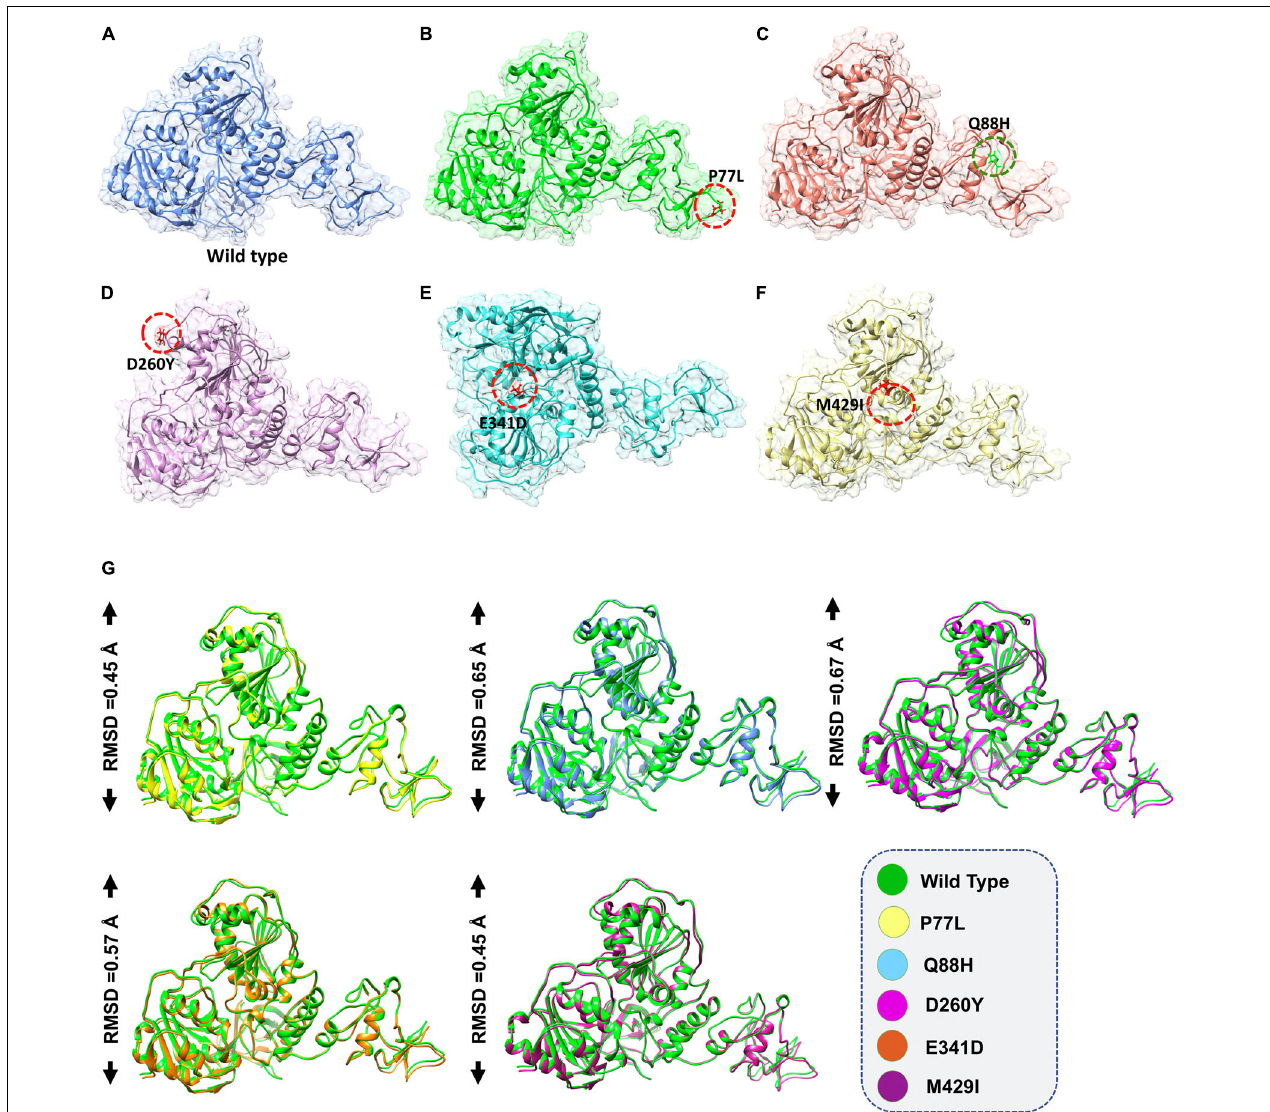
FIGURE 1 | Non-structural protein 13 (NSP13) mutant modeling and the superimposition of NSP 13 wild-type (WT) with NSP 13 mutants. (A) NSP13 WT, (B) P77L, (C) Q88H, (D) D260Y, (E) E341D, and (F) M429I. (G) Superimposed structure of NSP13 WT (green) with P77L (yellow), Q88H (cyan), D260Y (light magenta), E341D (orange), and M429I (dark magenta). The root mean square deviation (RMSD) values of each superimposition are